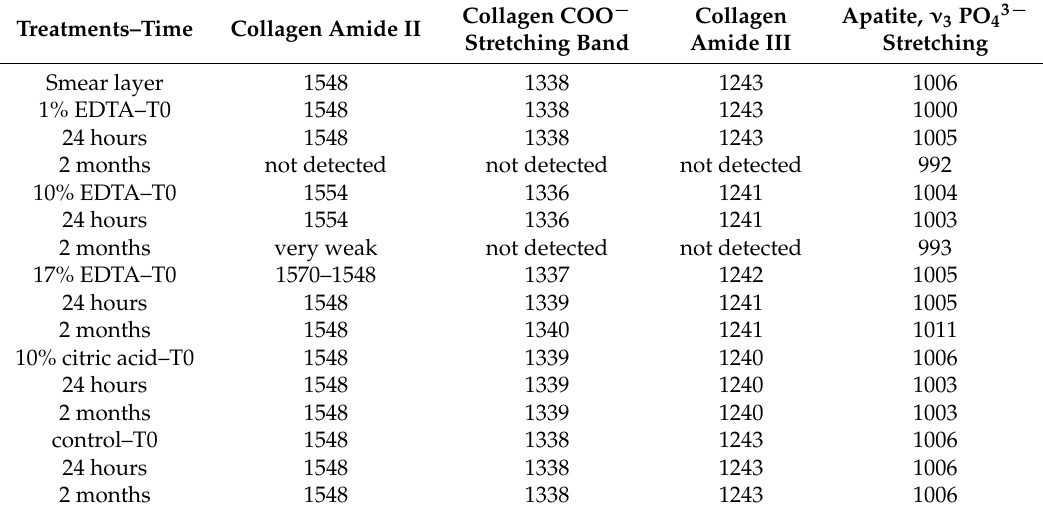
Table 5. IR band wavenumber positions (cm − 1